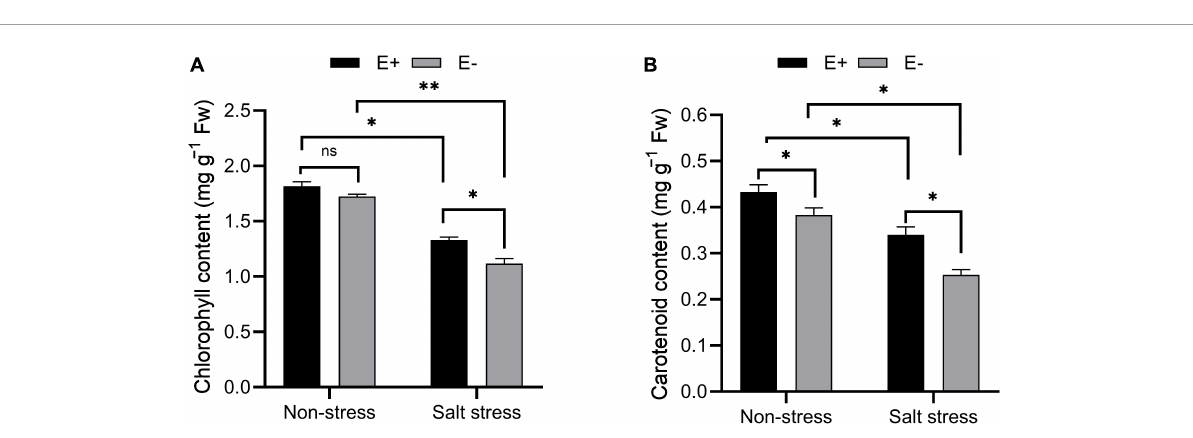
FIGURE4 Estimation of photosynthetic pigments. Chlorophyll (A) and carotenoid (B) contents of bermudagrass with inoculated and uninoculated plants under salt stress. Bars denote means ± SE of four treatment. “Non-stress” represents bermudagrass grown without NaCl condition; “Salt stress” represents bermudagrass under 250 mM salt conditions. “E + ” represents the infection of Enterobacter ludwigii , “E − ” represents the absence of E. ludwigii. “ ∗ ,” “ ∗∗ ,” indicate significant differences at P < 0.05, and P < 0.01, respectively, and ‘ns’ represents no significant difference.